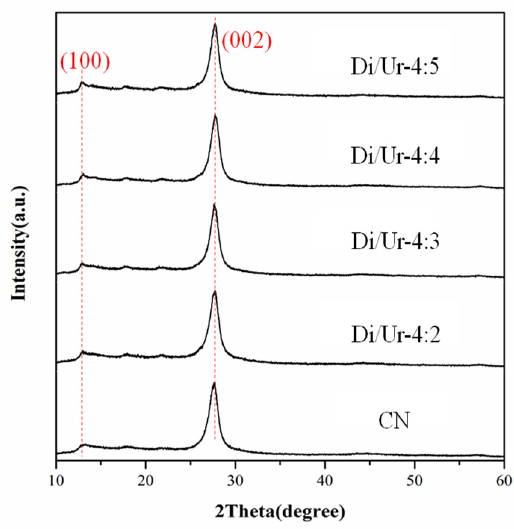
Figure 1. XRD patterns of g-C 3 N 4 and Di/Ur composites.